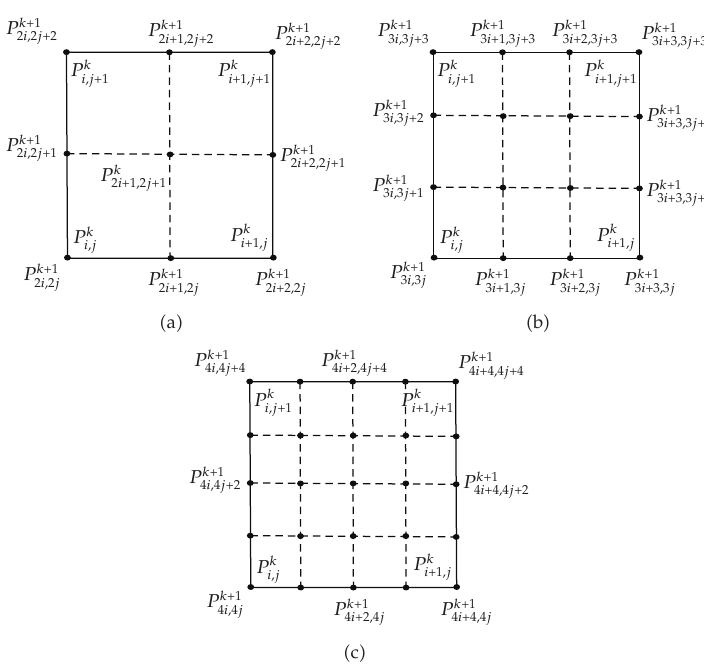
Figure 2: Solid lines show one face of coarse polygons whereas doted lines are refined polygons. (cid:3) a (cid:4) – (cid:3) c (cid:4) can be obtain by subdividing one face into four, nine and sixteen new faces by using (cid:3) 2.3 (cid:4) for n (cid:9) 2 , 3 , 4 (cid:3) i.e., binary, ternary and quaternary (cid:4) ,